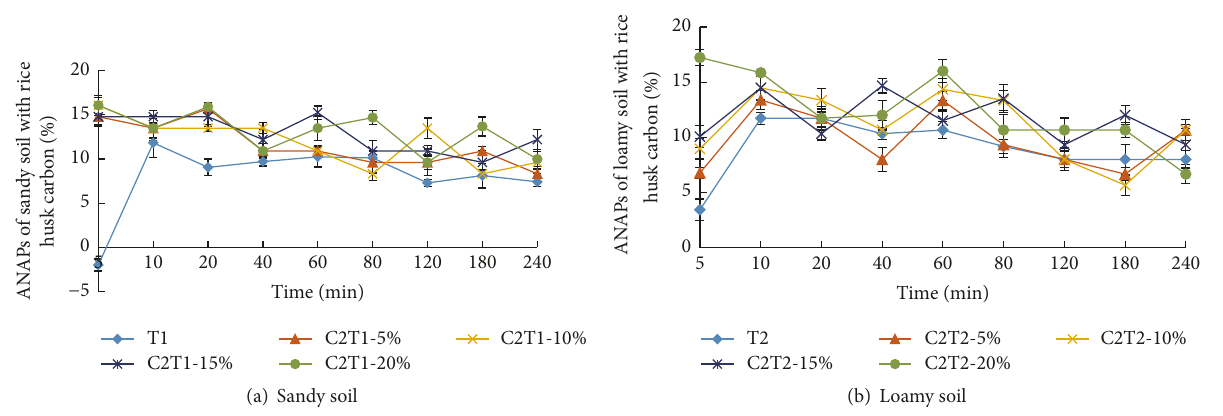
Figure 4: Effects of rice husk carbon (C 2 ) on soil adsorbing NH 4+ -N in biogas